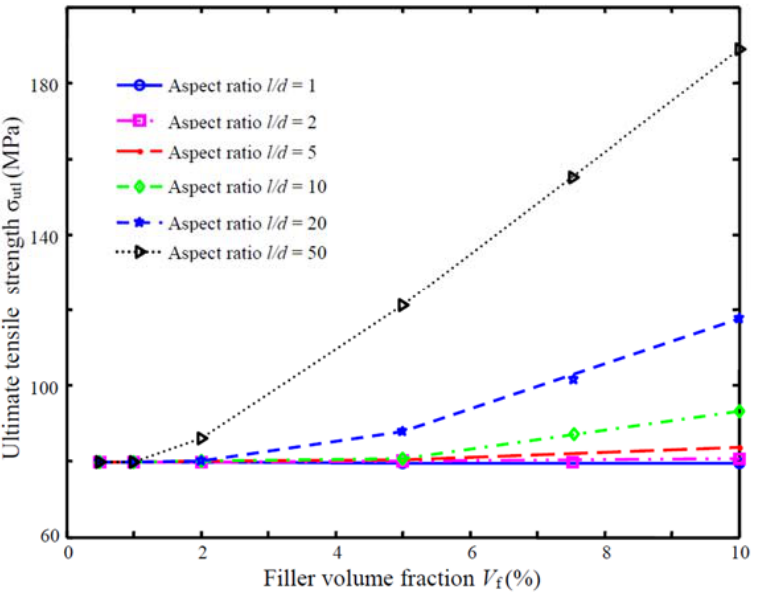
Figure 5. Variation of the effective ultimate tensile strength σ utl with the filler volume fraction V f .